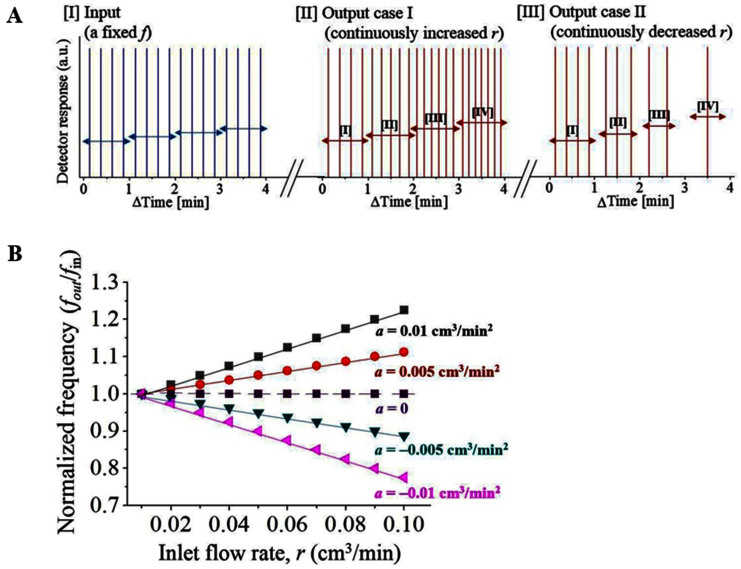
(a) Representative result of f change according to the designed r (a, acceleration). [I] Input at a fixed f and designed r. [II] Output case I: fout increases with continuously increasing r. [III] Output case II: fout decreases with continuously decreasing r. (b) Graphical summary of the results obtained in (a). Without acceleration (a = 0), fout/fin maintains unity according to r. fout/fin linearly increases with positive a, but linearly decreases with negative a. These results exhibit typical particle-like behavior of permeate molecules under acceleration caused by increased r. Considering the fixed path-length of the system, the result reflects the linear mass-energy relation.